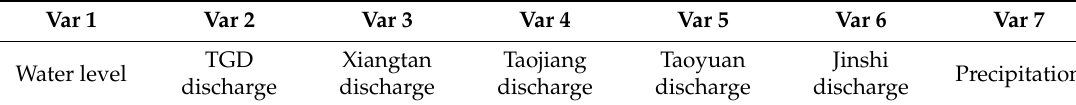
Table 2. Selected variables.